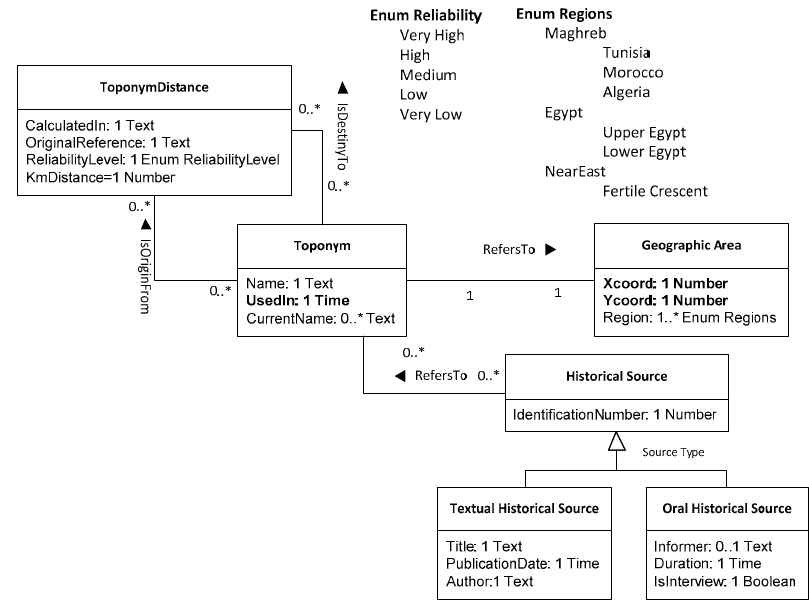
Figure 1. ConML class model for Toponym Studies in DICTOMAGRED